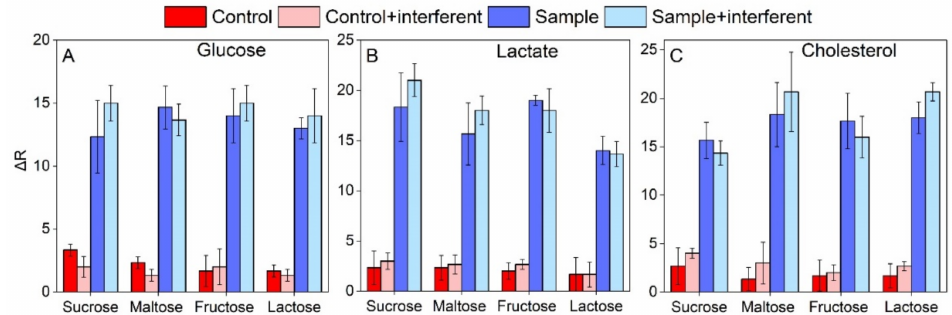
Figure 6. ∆ R values collected at the end of the assay (10 min) performed on native saliva (red histograms), saliva with interferents (pink histograms), saliva spiked with ( A ) 14 µ M glucose, ( B ) 2 mM lactate, and ( C ) 5.2 µ M cholesterol (dark blue histograms), and saliva spiked with a mix of the analytes and the interferents (light blue histograms). Error bars represents the uncertainty from three independent measurements.